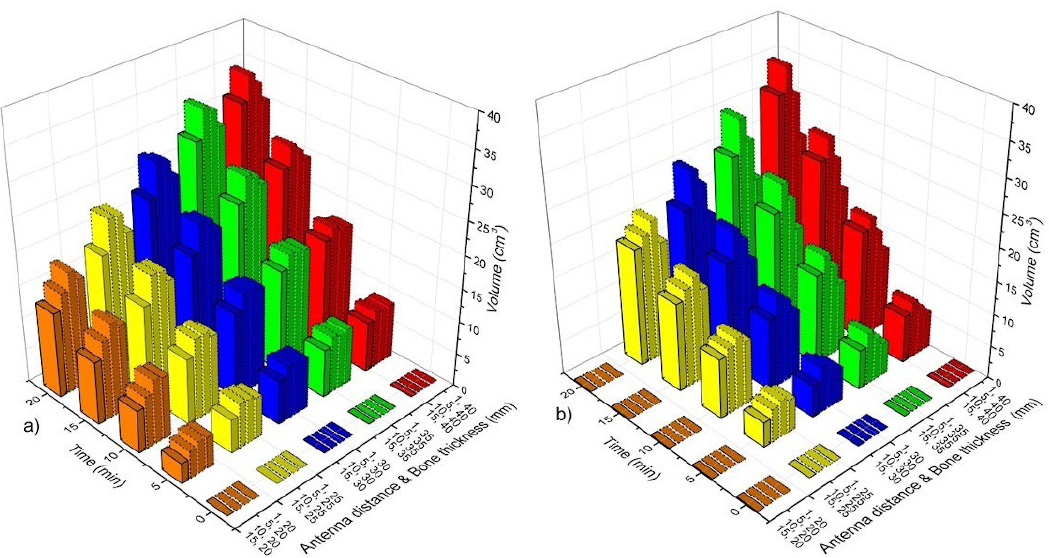
Figure 8. Bone tissue volume at ablation temperatures (T > 55 ◦ C) as a function of time, antenna